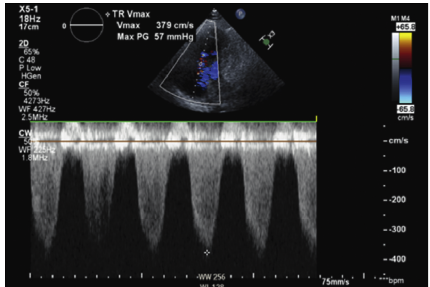
Figure 2: Continuous wave-Doppler study showing tricuspid insufficiency with an estimate peak pressure gradient of 57mm